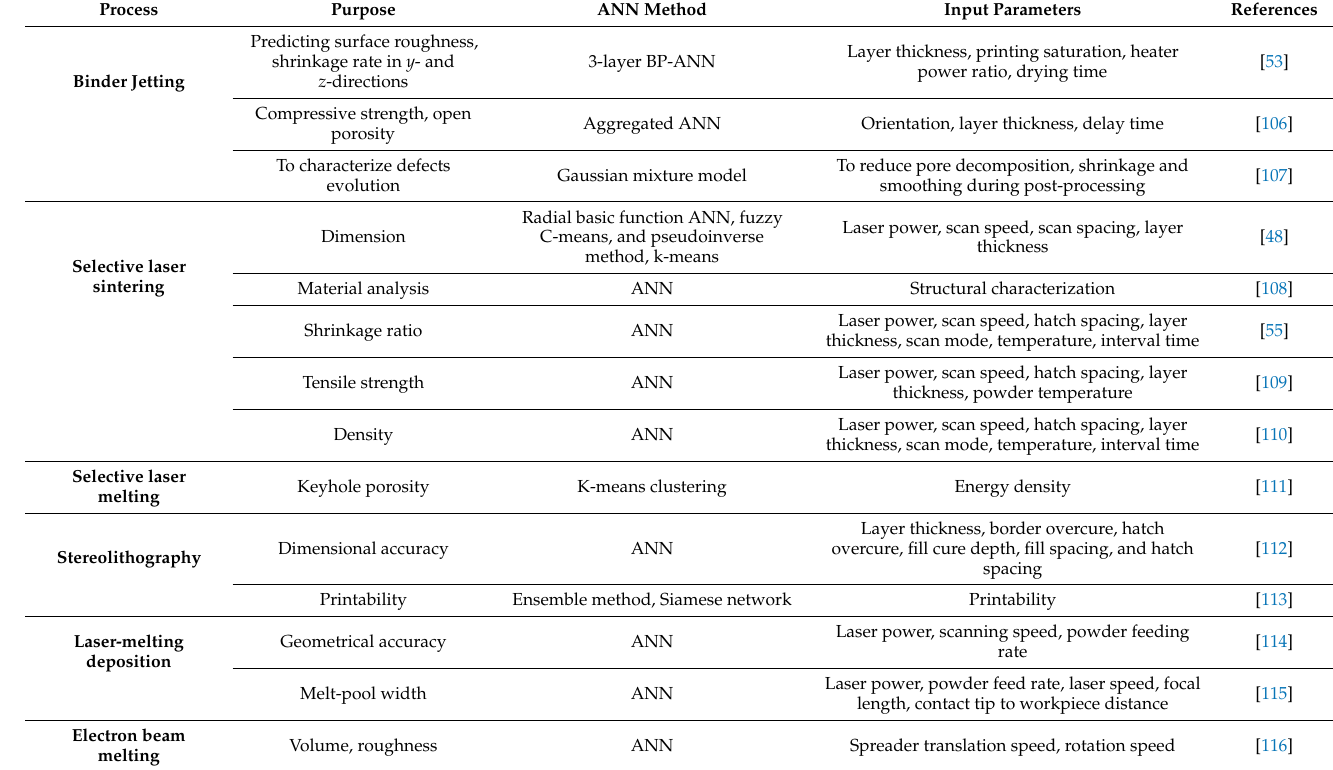
Table 7. The use of an ANN for process optimization of 3D